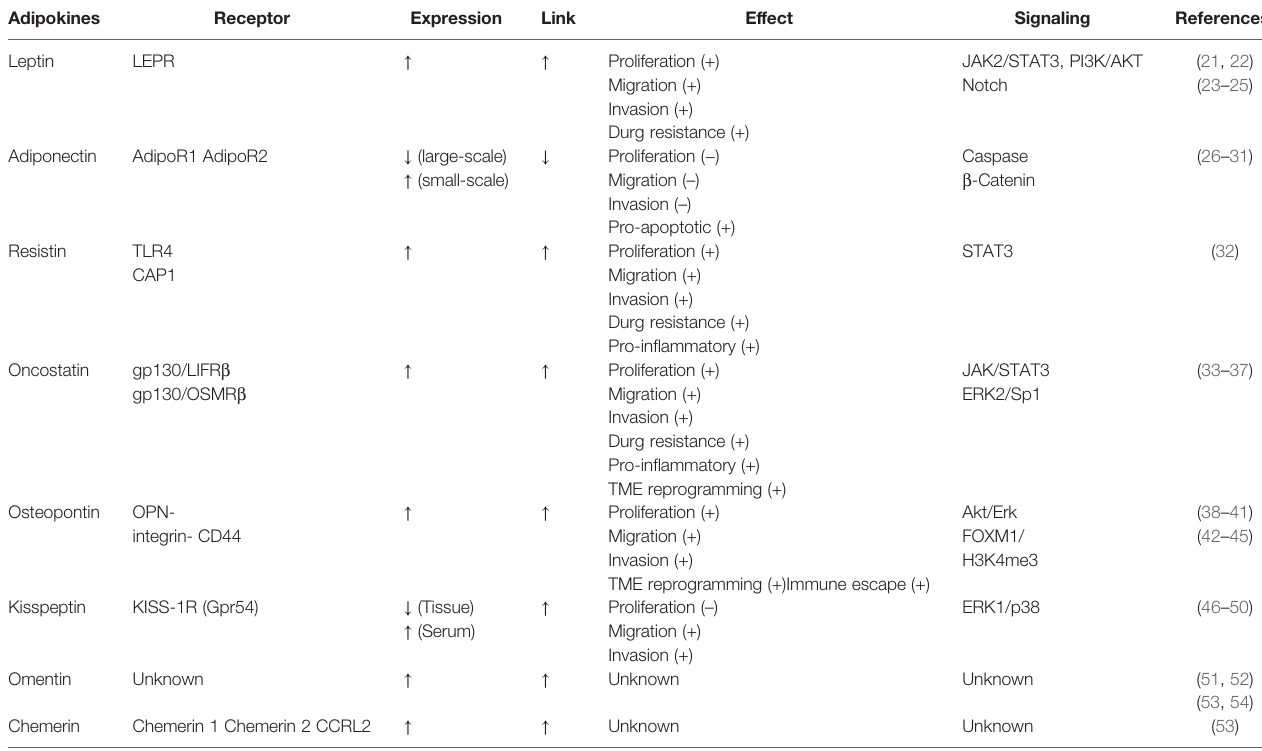
TABLE 1 | Effect of Adipokines on